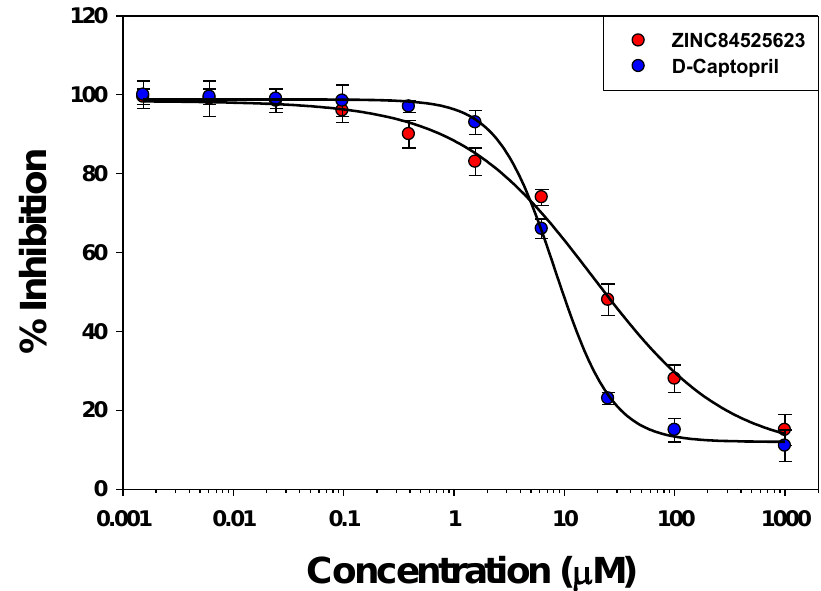
Figure 6. The determination of the IC 50 values of ZINC84525623 (red), and D -captopril (blue).